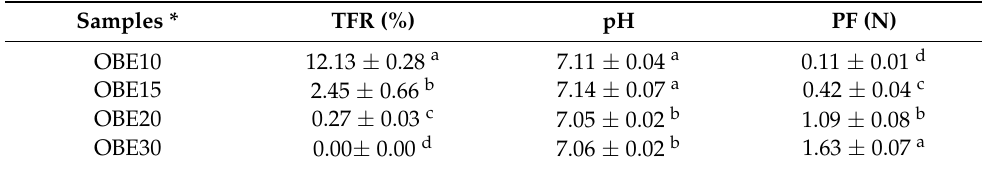
Table 2. Total fluid release (TFR, %), pH values, and penetration force (PF, N) of oat bran O/W. Samples